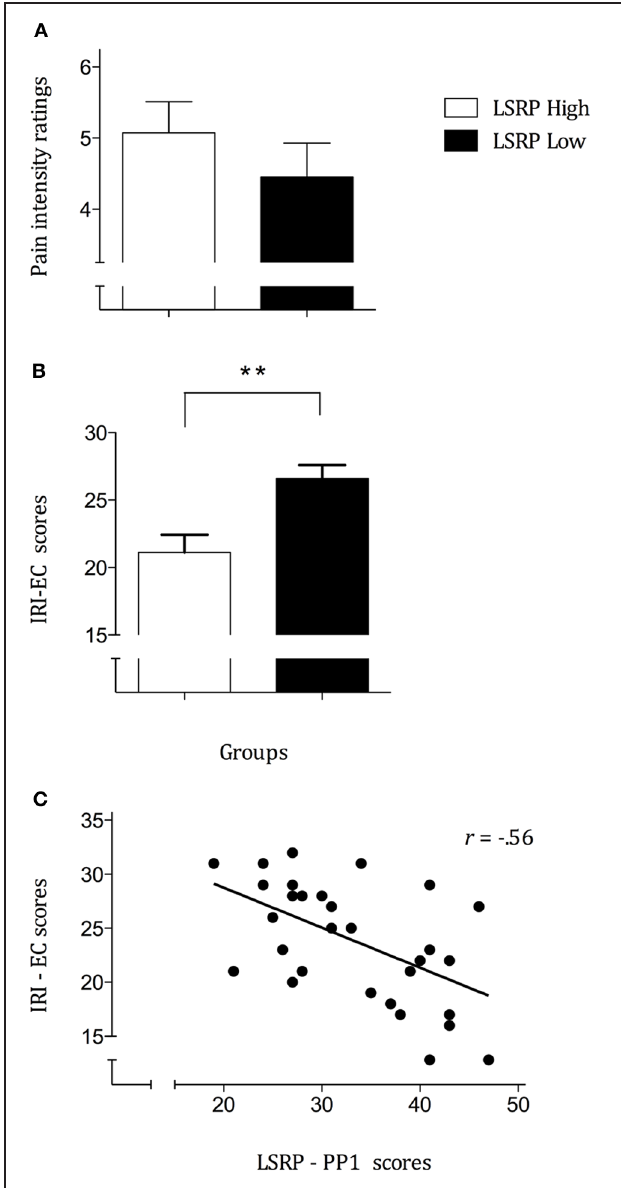
FIGURE 2 | (A) Mean pain ratings for each group indicating an absence of significant difference ( p = 0 . 35) between LSRP_High and LSRP_Low; (B) Self-reported Empathic Concern (EC) scores significantly differed between LSRP_High and LSRP_Low group; (C) Negative correlation between primary psychopathy (PP1) scores and empathic concern scores. ∗∗ p < 0 . 01.